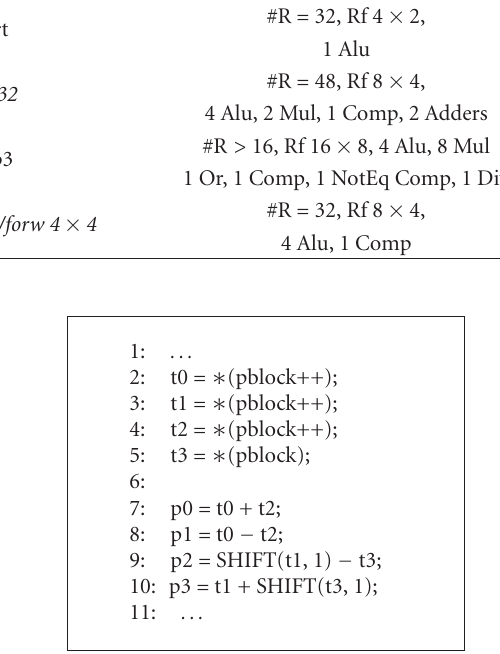
Algorithm 3: Part of inverse4 × 4 C